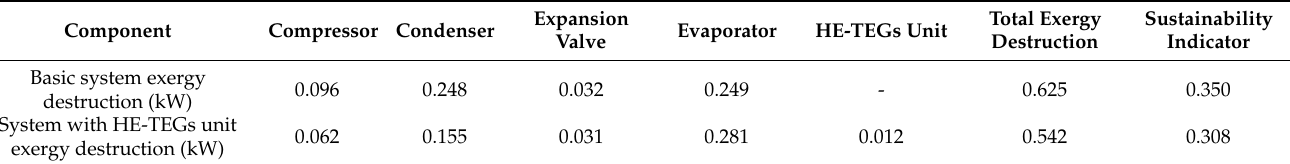
Table 3. Exergy destruction analysis of present refrigeration system with and without using HE-TEGs unit *.